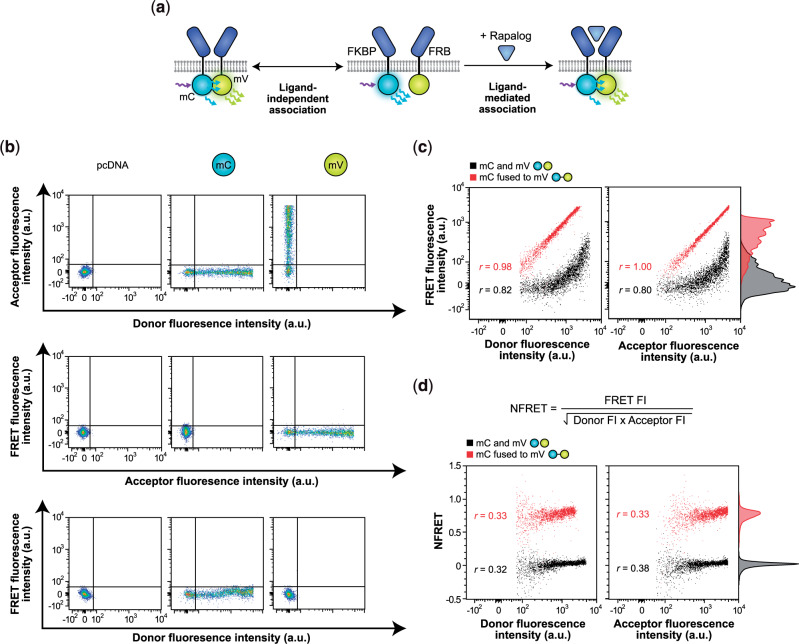
Development of a flow cytometric FRET approach to probe receptor chain association. (a) This schematic illustrates our strategy for quantifying ligand-independent (left) and ligand-mediated (right) receptor associations using Förster resonance energy transfer (FRET). Rapamycin-sensing MESA receptor ICDs were replaced with mCerulean (donor) and mVenus (acceptor) fluorophores. (b) Single-fluorophore samples were used to linearly compensate bleed-through from individual fluorophores into both the other fluorophore channel and the FRET channel. These plots also illustrate the gating used to identify cells expressing both the donor and acceptor fluorophores (mCerulean+/mVenus+). mC, mCerulean; mV, mVenus. (c) Cytosolically expressed control constructs that are expected to display low FRET (separate soluble donor and acceptor proteins) or high FRET (donor–acceptor fusion protein) differ by a vertical shift in fluorescence in the FRET channel. Fluorescence in the FRET channel is linearly correlated with donor and acceptor fluorescence, respectively. The cells shown are singlets that are transfected (miRFP670+) and that express the donor and acceptor (mCerulean+/mVenus+). (d) When FRET fluorescence is normalized to donor and acceptor fluorescence intensities by the calculated NFRET metric (equation shown), the cytosolic controls still display a vertical shift in NFRET, but NFRET only has a low correlation with donor and acceptor fluorescence, respectively; NFRET is more independent of expression differences observed across the cell population (compared to FRET fluorescence intensity in c). The NFRET metric better distinguishes low and high FRET controls than does unprocessed FRET fluorescence. The cells shown are singlets that are transfected (miRFP670+) and that express the donor and acceptor (mCerulean+/mVenus+). Experiments were conducted in biological triplicate, and individual representative samples are shown. Adjunct histograms represent probability density and are scaled to unit area. Data were analyzed as described in Section 2.